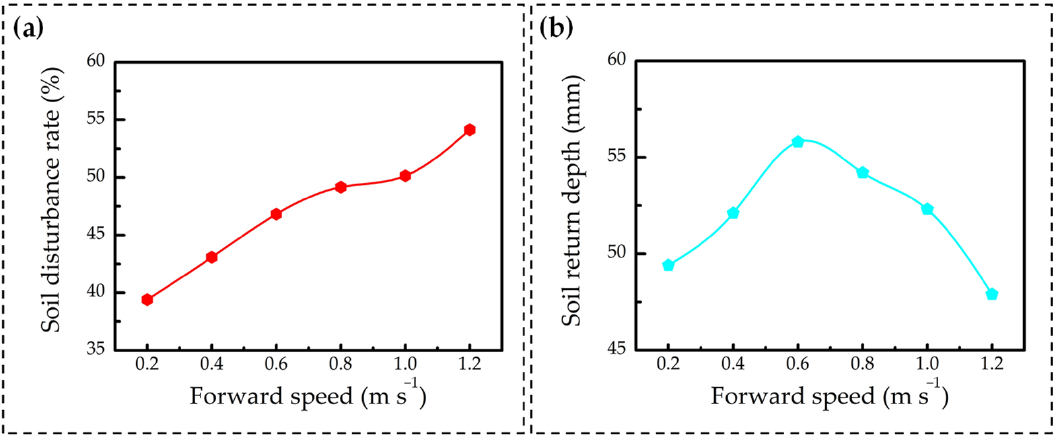
Figure 9. Soil bin performance test results. ( a ) Effect of working speed on soil-disturbance rate. ( b ) Effect of working speed on soil-return depth.